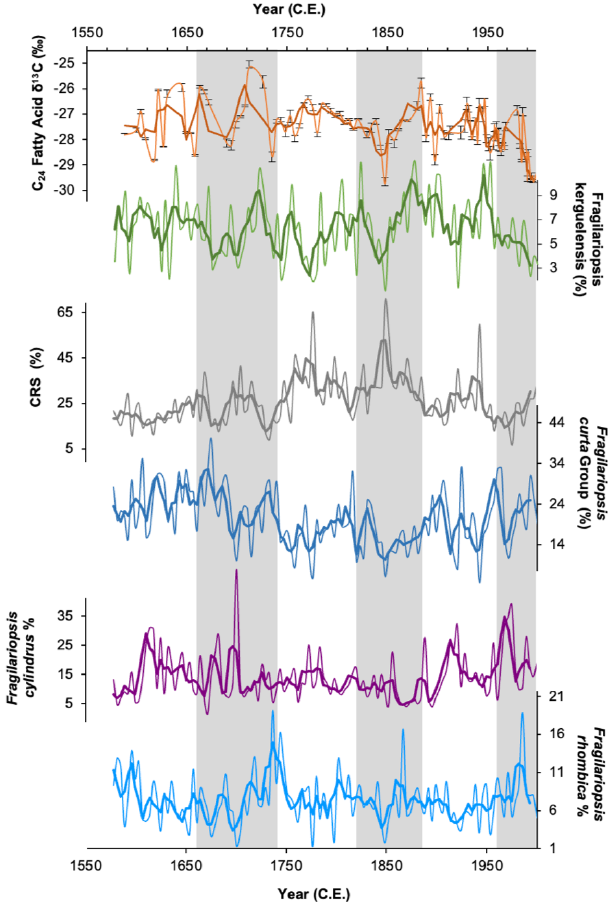
Figure 6. δ 13 C values of the C 24 fatty acid (orange) and relative abundances (%) of the open-water diatom Fragilariopsis kergue- lensis (green). Also shown are relative abundances of the four most abundant diatom groups in DTGC2011. Chaetoceros resting spores (CRS; grey line), Fragilariopsis curta group (dark blue line), Fragi- lariopsis cylindrus (purple line) and Fragilariopsis rhombica (light- blue line). The thick line represents the three-point moving average for each. Grey vertical bands highlight periods where C 24 fatty acid δ 13 C is in phase with F. kerguelensis